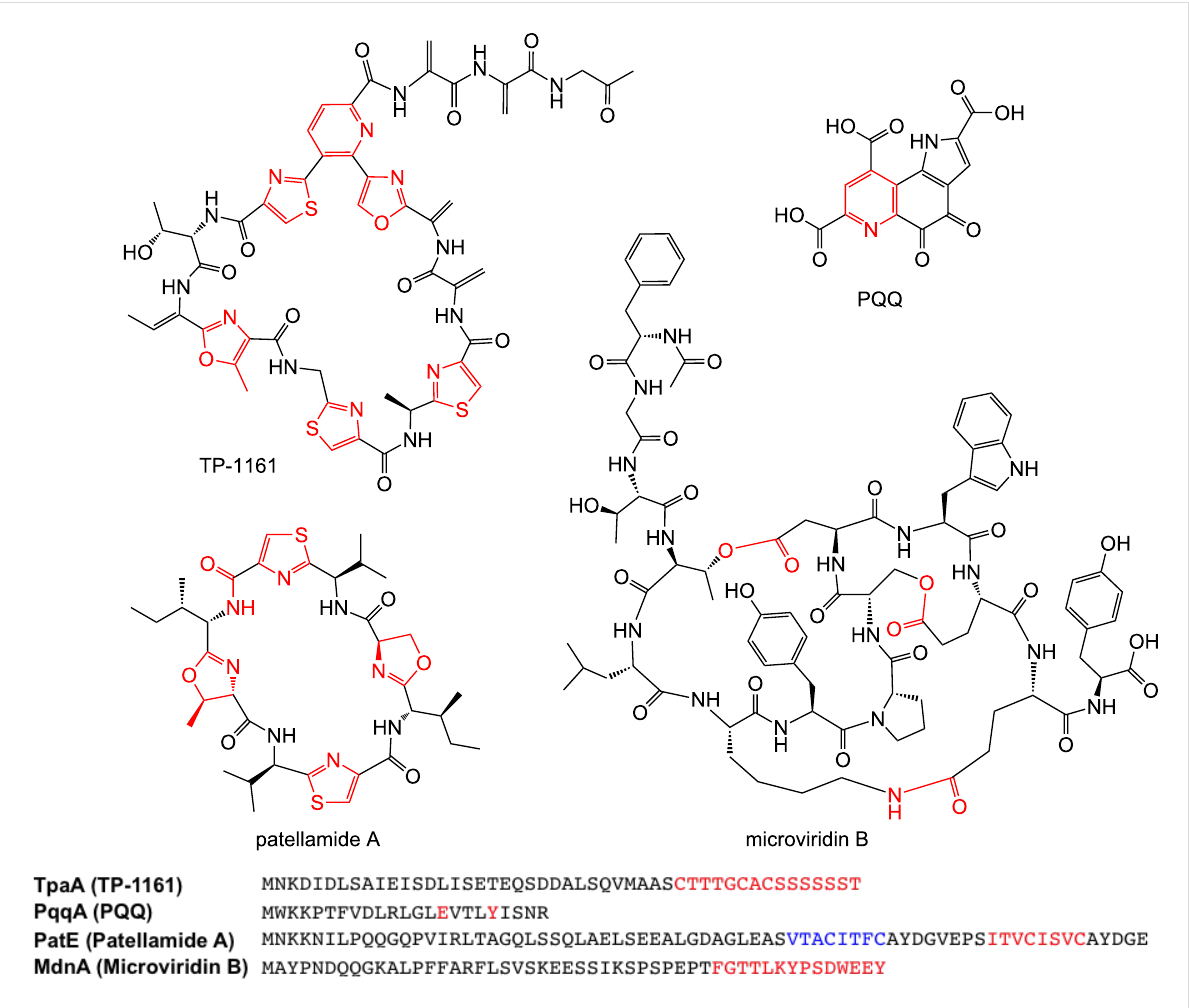
Figure 2: Examples of heterocycles in RiPPs alongside the precursor peptides that these molecules derive from. The red features on the molecules indicate where cyclisation has taken place, while the sections of the sequences highlighted in red correspond to the core peptides for each of these molecules. The sequence highlighted in blue in PatE corresponds to the core peptide for patellamide C, another macrocyclic RiPP that contains thia- zoles and